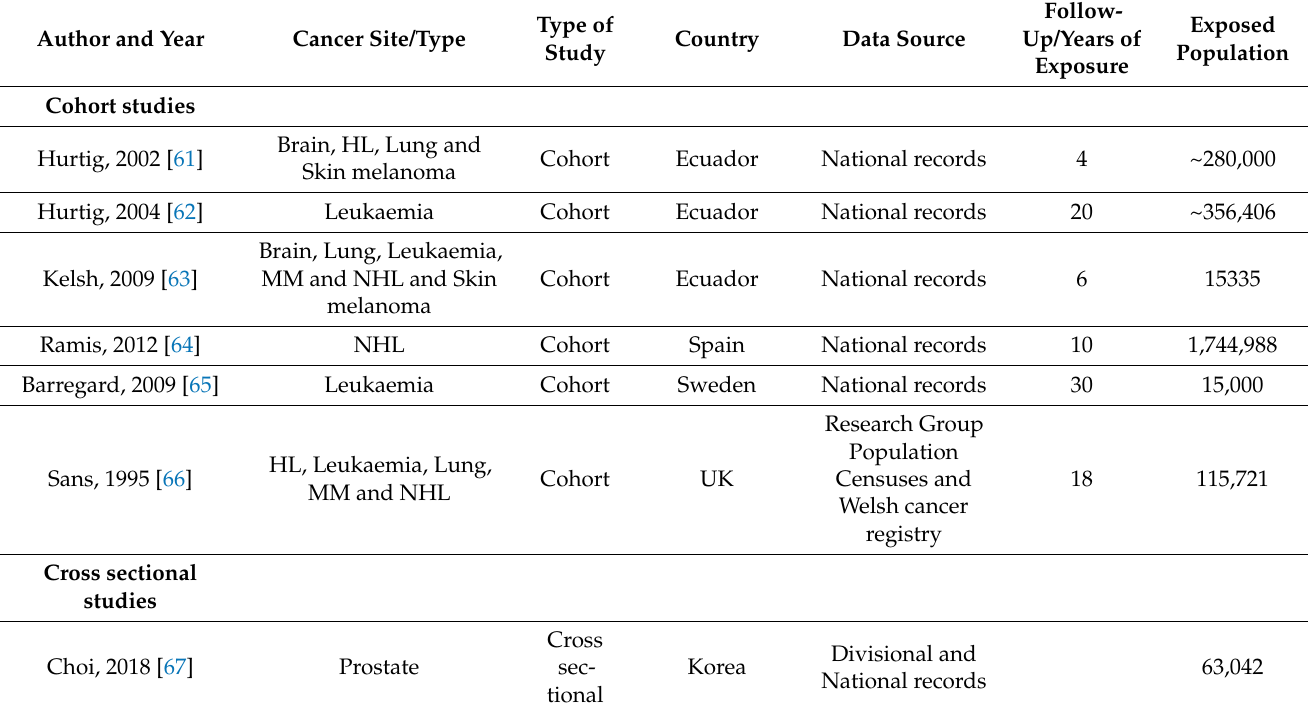
Table 2. Characteristics of studies of residents living near petroleum